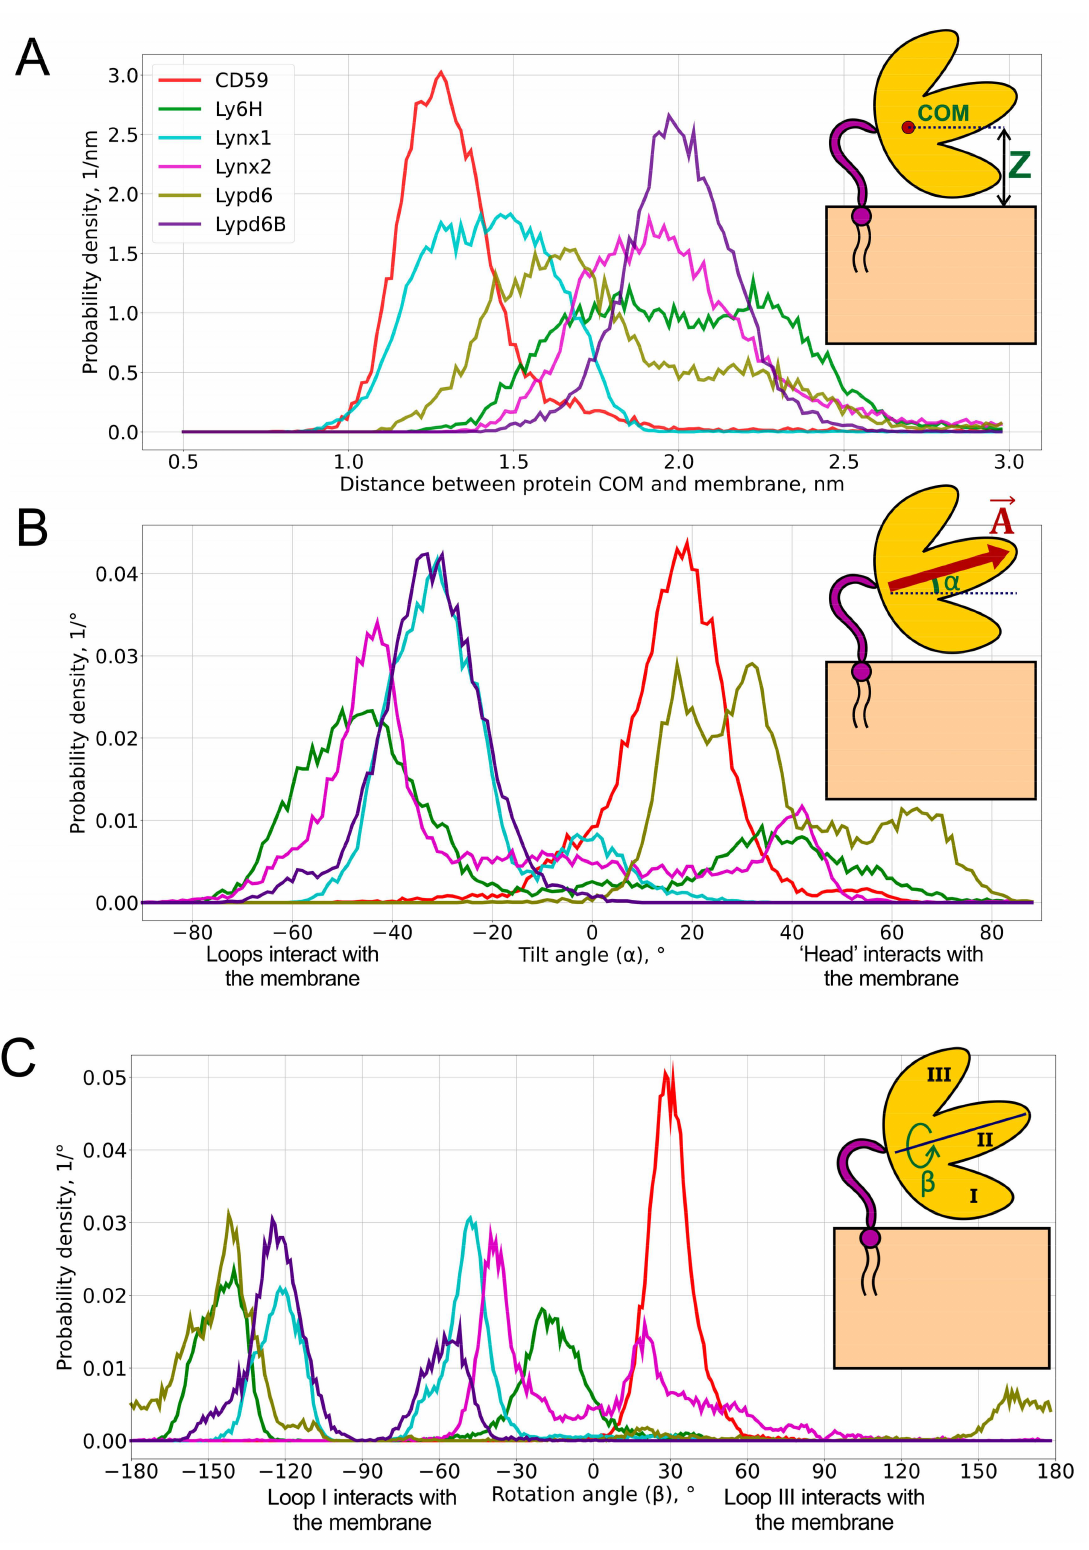
Figure 2. Probability distributions of the center of mass (COM) position (A), tilt angle α (B), and rota- tion angle β (C) of GPI-anchored Ly6 proteins in the membrane. Pictograms describing these parameters are shown as insets . Median values and standard deviations of the observed distributions are provided in Table 1. 2D histograms of probability density in α / β -coordinates are represented in Figure